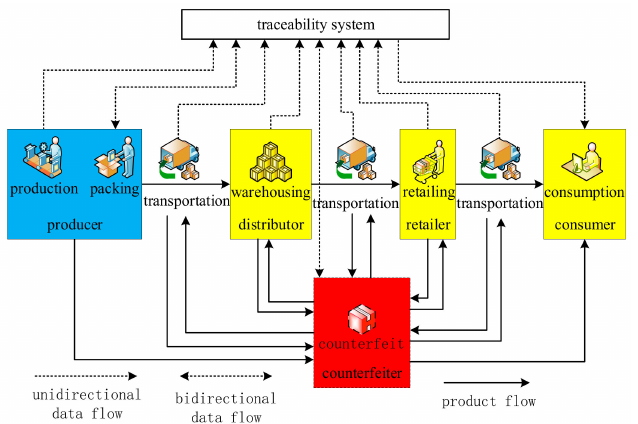
Figure 2. A typical product life cycle and counterfeiting analysis in the supply